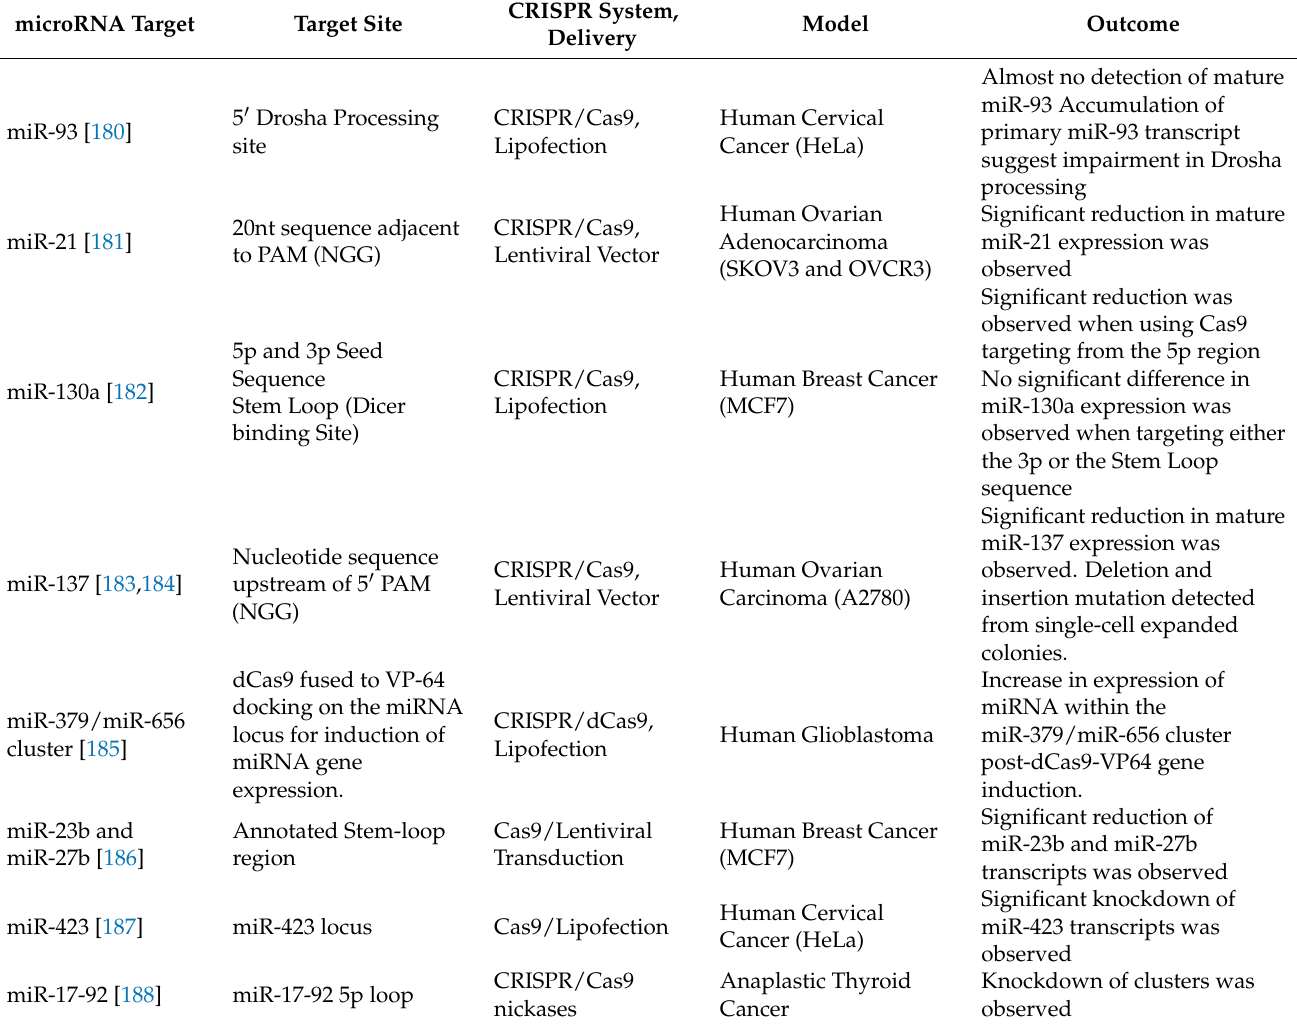
Table 3. Table showing miRNA target using CRISPR/Cas9 via different modes at miRNA processing